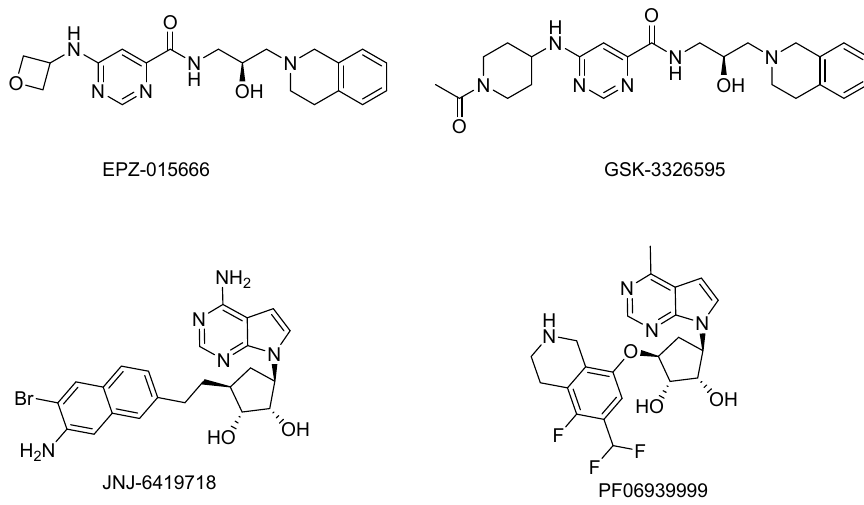
Figure 1. Chemical structures of some representative PRMT5 inhibitors.